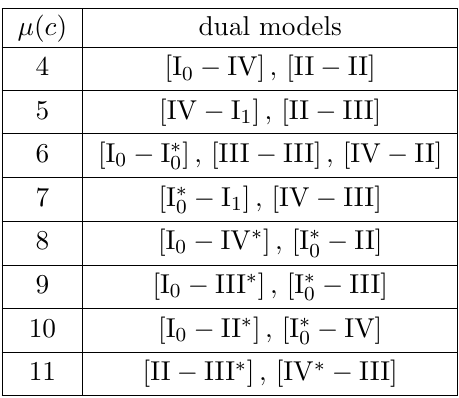
Table 3. Dual models: the NU degenerations in the same row give rise to the same LSTs after resolution of the dual F-theory